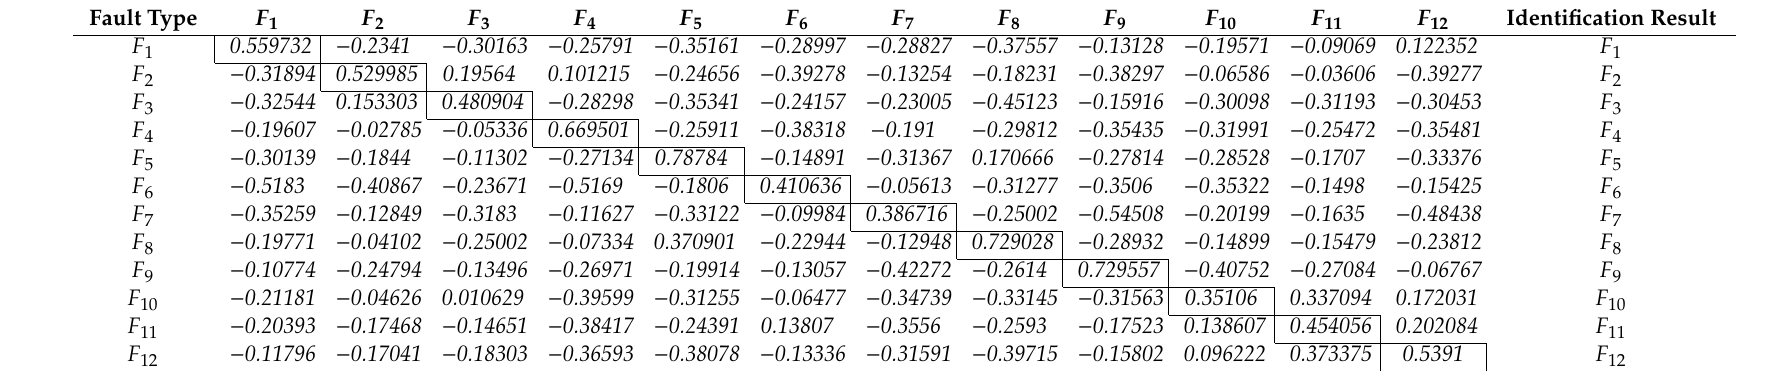
Table 4. Results for the identification of di ff erent switch faults in an inverter working at 40 Hz.